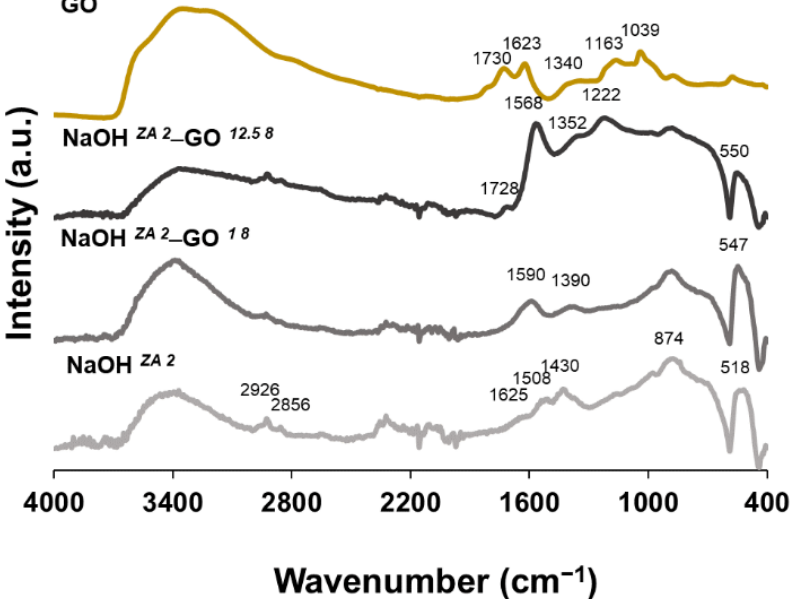
Figure 4. ATR-FTIR spectra of GO, ZnO (NaOH ZA 2 ) and ZnO–rGO structures varying the concen- tration of GO suspension: 1 mg/mL (NaOH ZA 2 –GO 1 8 ) and 12 mg/mL ((NaOH ZA 2 –GO 12.5 8 ).